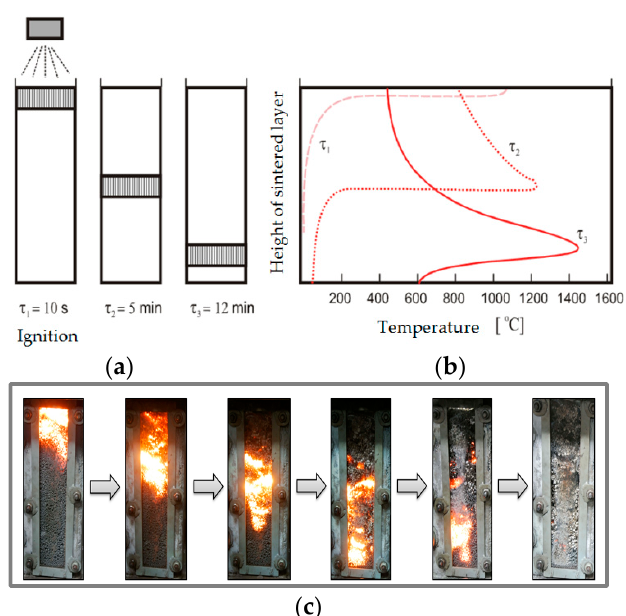
Figure 2. Course of sintering and temperature distribution in the static sintered layer—reproduced from [3,5]. ( a ) Progress of the combustion zone after the ignition of the charge surface at sintering times τ 1– τ 3 ; ( b ) temperatures in sintered layer at sintering times τ 1– τ 3 ; and ( c ) visible fuel burning zone the sintering in the sintering pan.